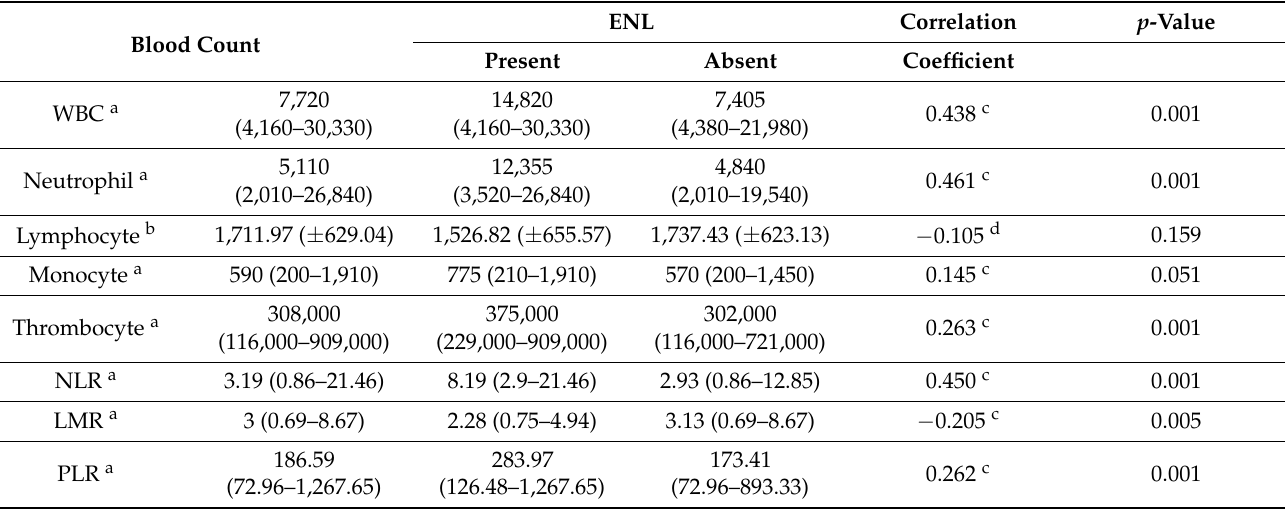
Table 2. Blood count of new MB leprosy